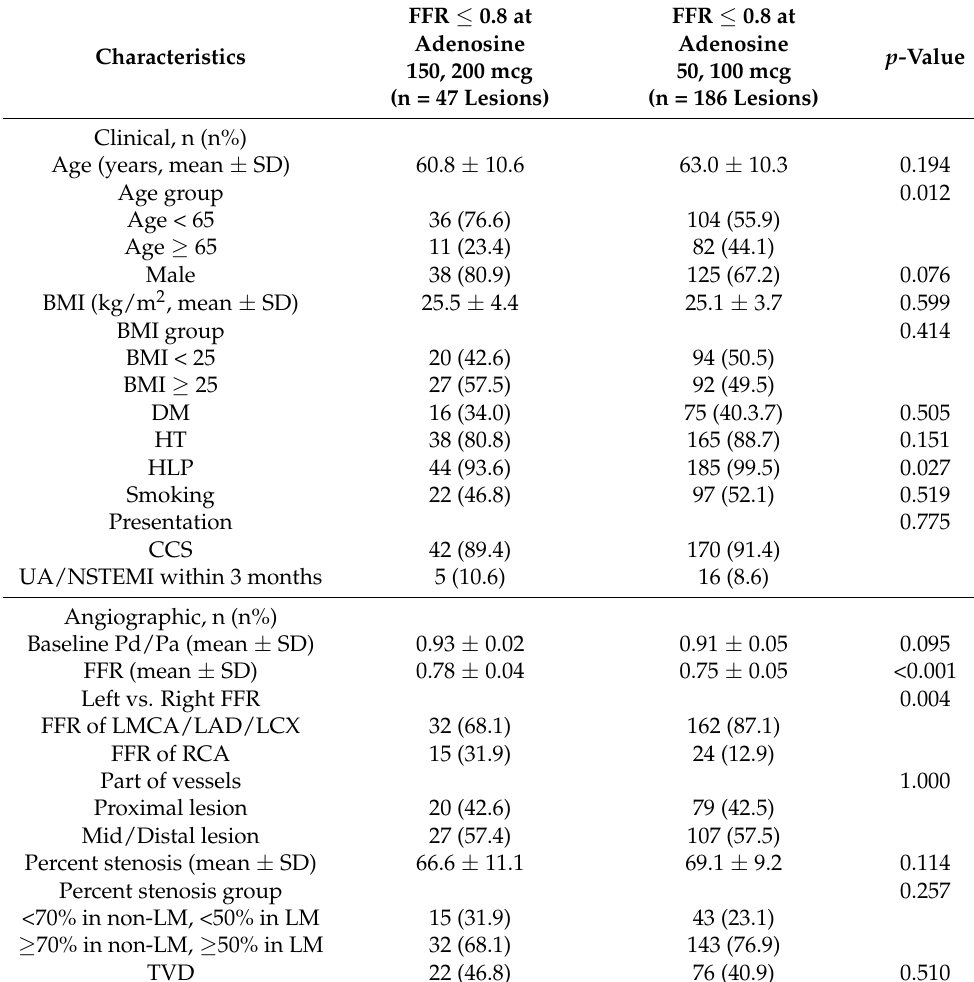
Table 3. Comparison of clinical and angiographic characteristics between coronary stenotic lesions with FFR ≤ 0.8 at adenosine 150, 200 mcg and lesions with FFR ≤ 0.8 at adenosine 50, 100 mcg. Characteristics